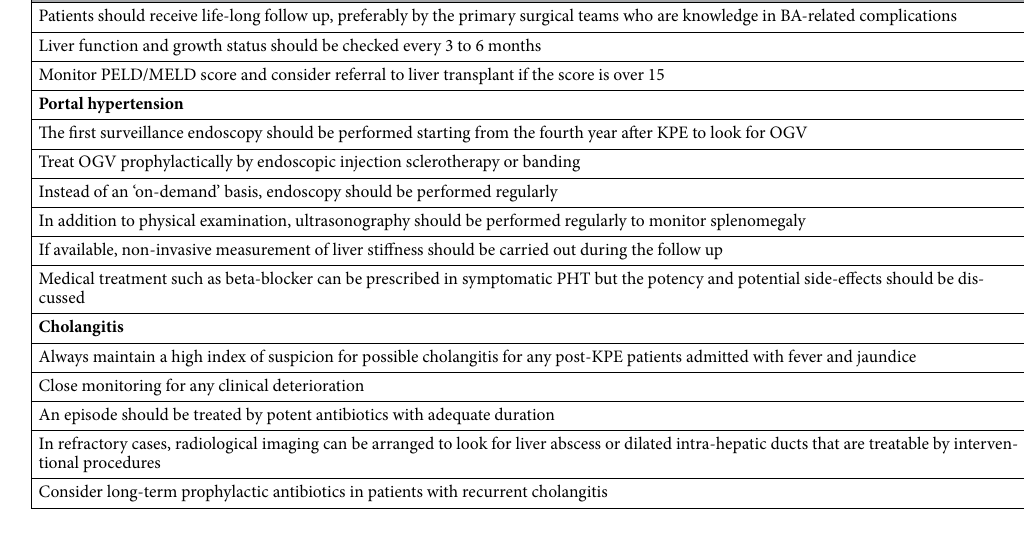
Table 4. Recommended management strategies of patients living with native livers after